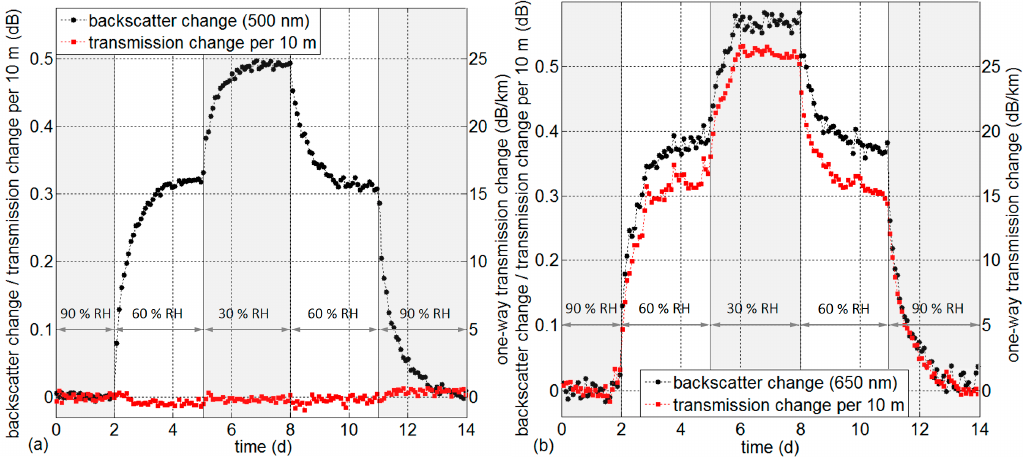
Figure 4. Backscatter change and transmission change during step-wise RH changes for ( a ) 500 nm and ( b ) 650 nm.